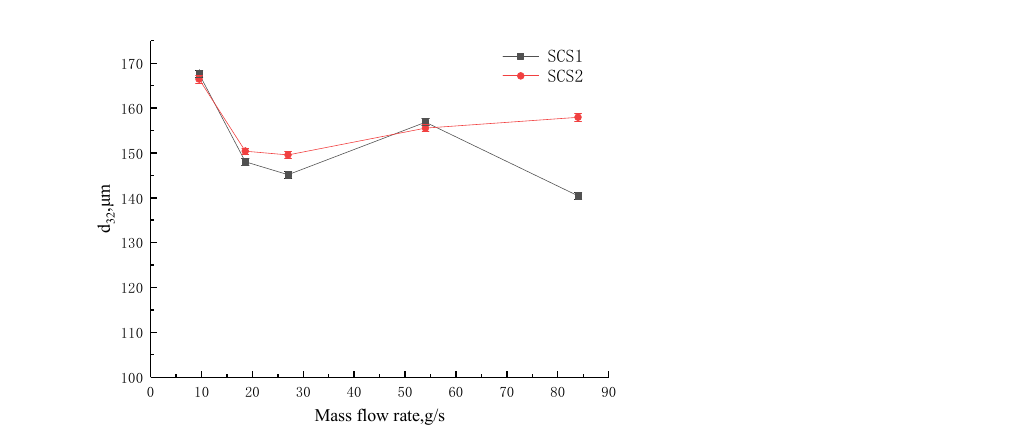
Figure 6. Average length diameters d 10 of the atomization field under different mass flow rates.